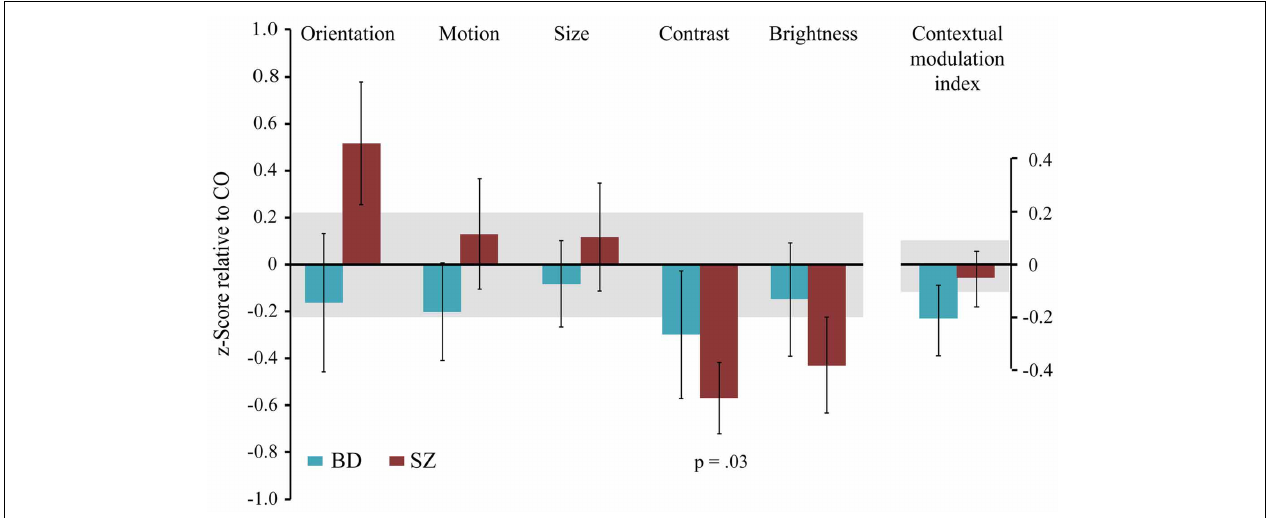
FIGURE 3 | The magnitude of contextual modulation in BD and SZ. The magnitude of contextual effect in individuals with bipolar disorder (BD) and individuals with schizophrenia (SZ) was converted into z scores for each task relative to the respective mean and variance of the control group. The contextual modulation index represents the average z score across tasks for each participant. Negative values indicate weaker